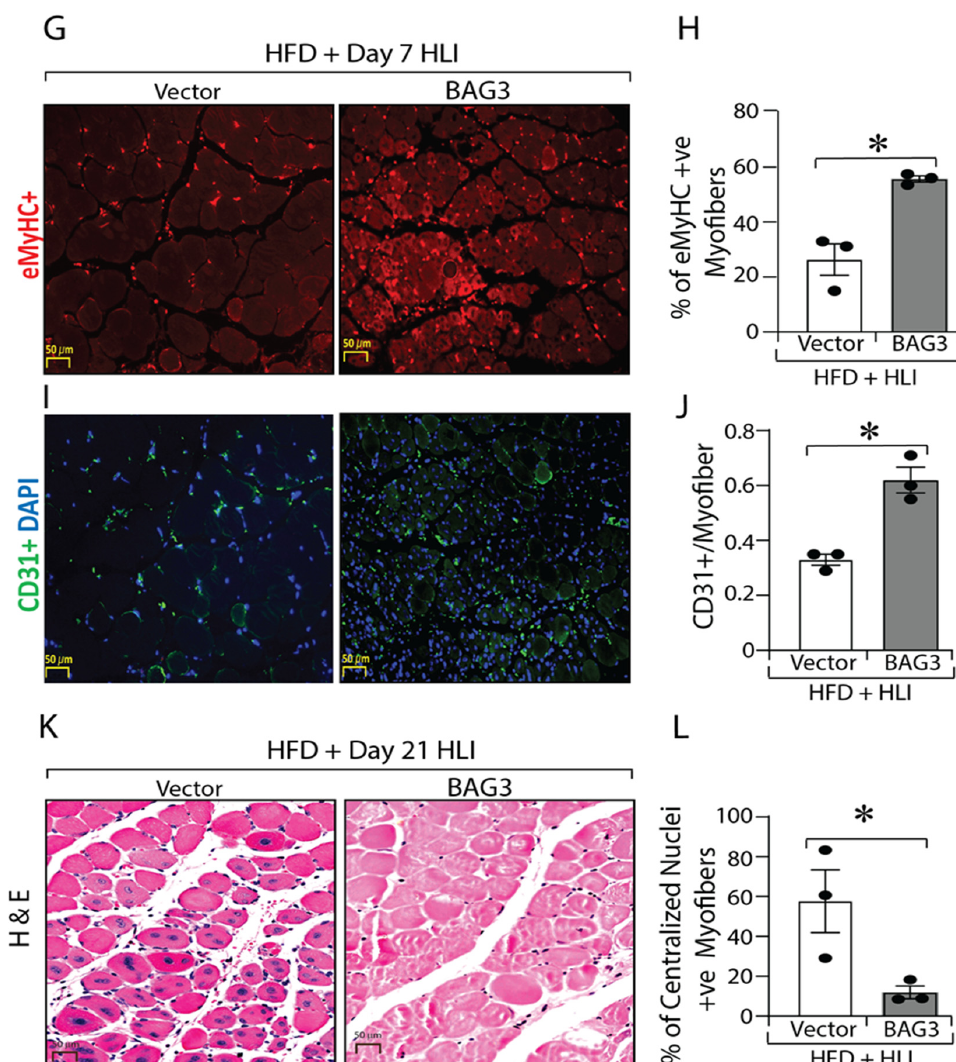
Figure 6. BAG3 overexpression improves necrosis score, perfusion recovery, muscle function and muscle regeneration in diabetic PAD. HLI surgery was performed on mice fed with HFD for 16 weeks. Mice were treated with AAV6-CMV (Vector) or AAV6-BAG3 (BAG3). BAG3 overexpression was confirmed in a subset of treated mice on day 7 post-HLI ( A , B ) n = 4. Necrosis score ( C , D ) n = 6, perfusion recovery ( E ) n = 4-6, and skeletal muscle function ( F ) n = 5 was determined. eMyHC+ staining ( G , H ) n = 3, CD31+ staining ( I , J ) n = 3 and H & E staining ( K , L ) n = 3 were carried out in GA muscle tissue. All the values are mean ± SEM. * p < 0.05 vs. vector.